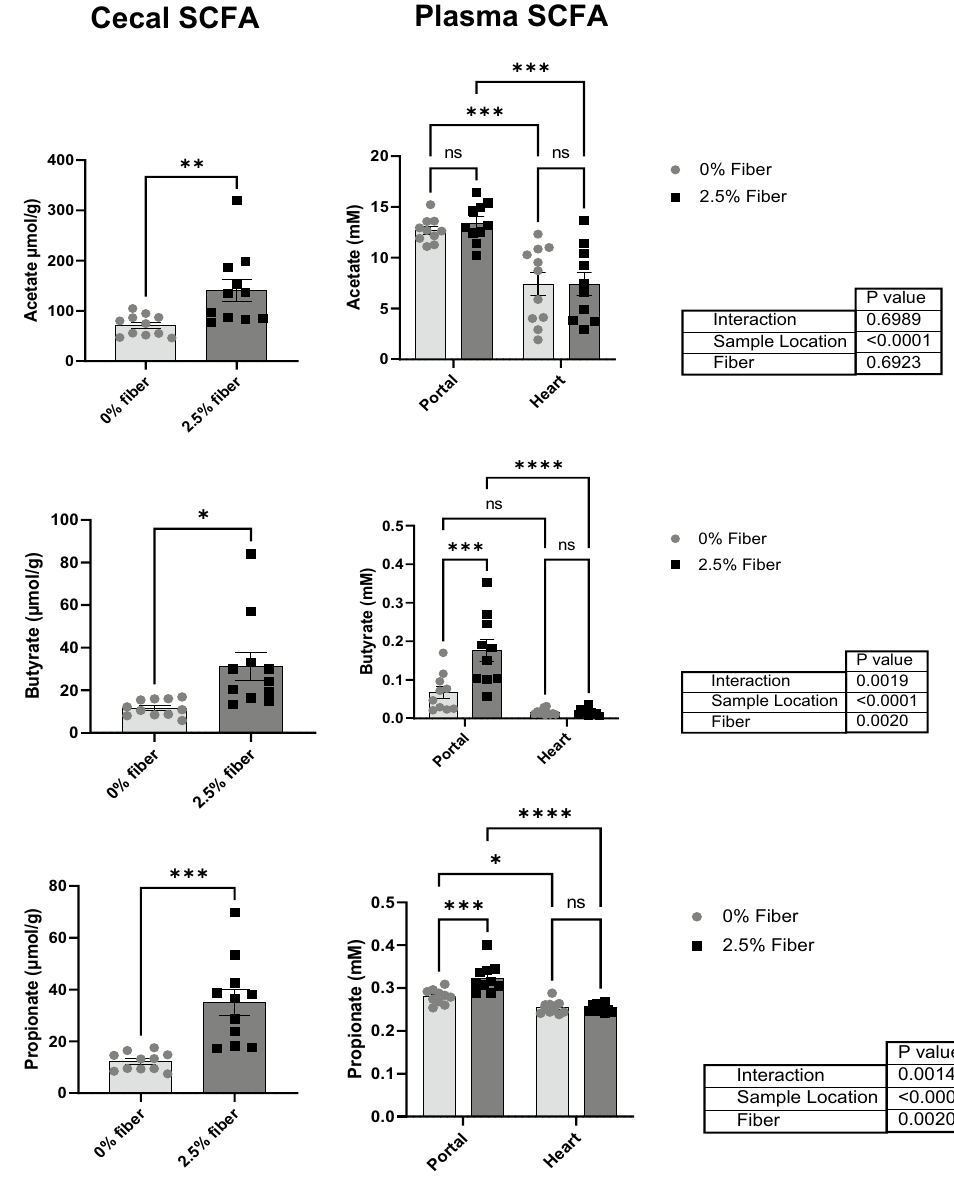
Figure 1. Effect of dietary fiber intake on the SCFAs (acetate, butyrate, and propionate) levels in the cecum, portal vein plasma, and heart plasma from mice fed 0 or 2.5% inulin for 2 weeks. Samples (0 or 2.5% inulin) were compared by unpaired t-test (cecal content) or 2-way ANOVA (sample location × diet) * P < 0.05, ** P < 0.01, *** P < 0.001, and **** P <